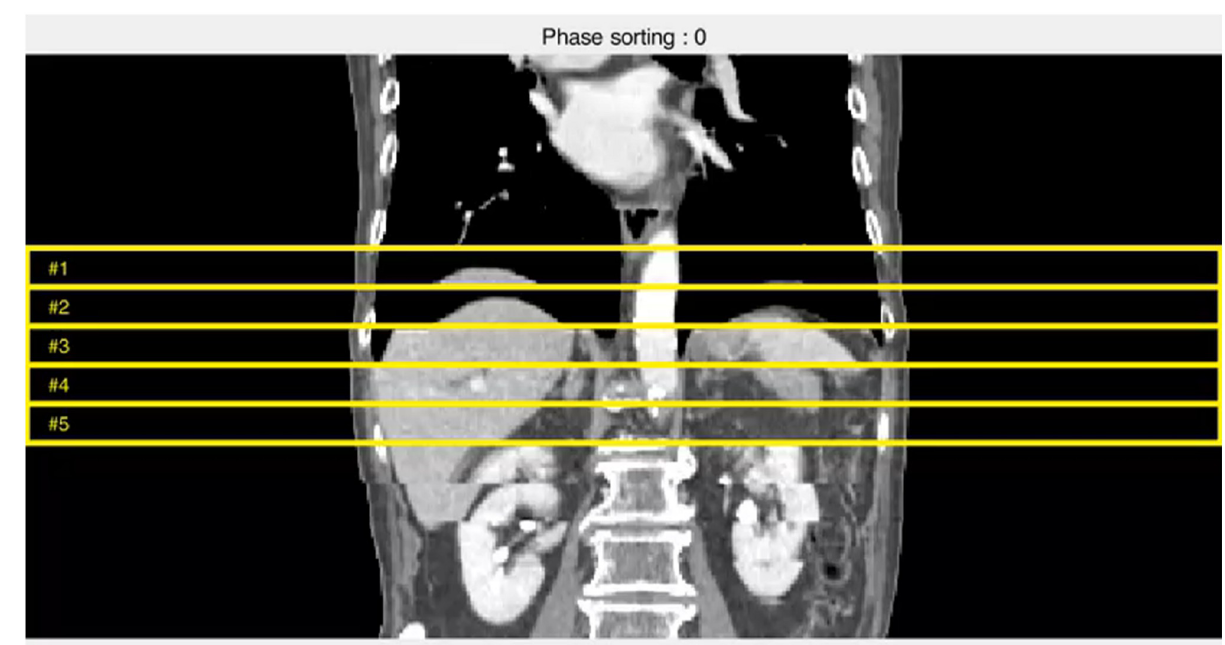
Fig 5. Coronal view of phase-sorted 4DCT and its evaluation regions of quantitative indicators for RMA.